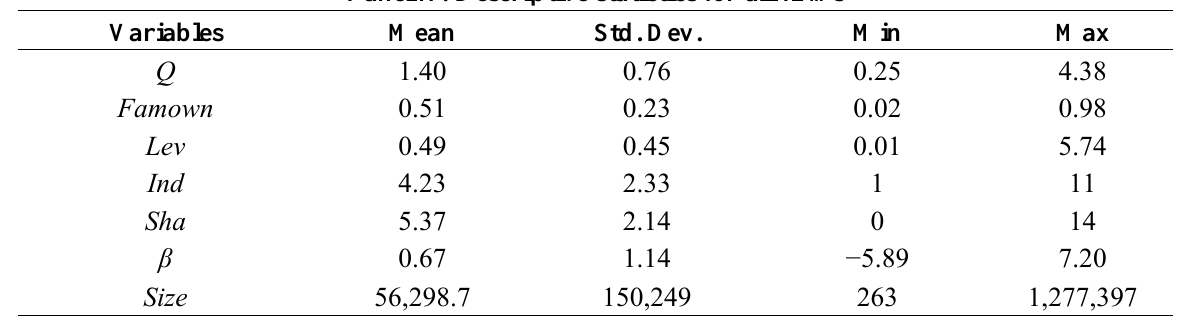
Panel A: Descriptive statistics for all